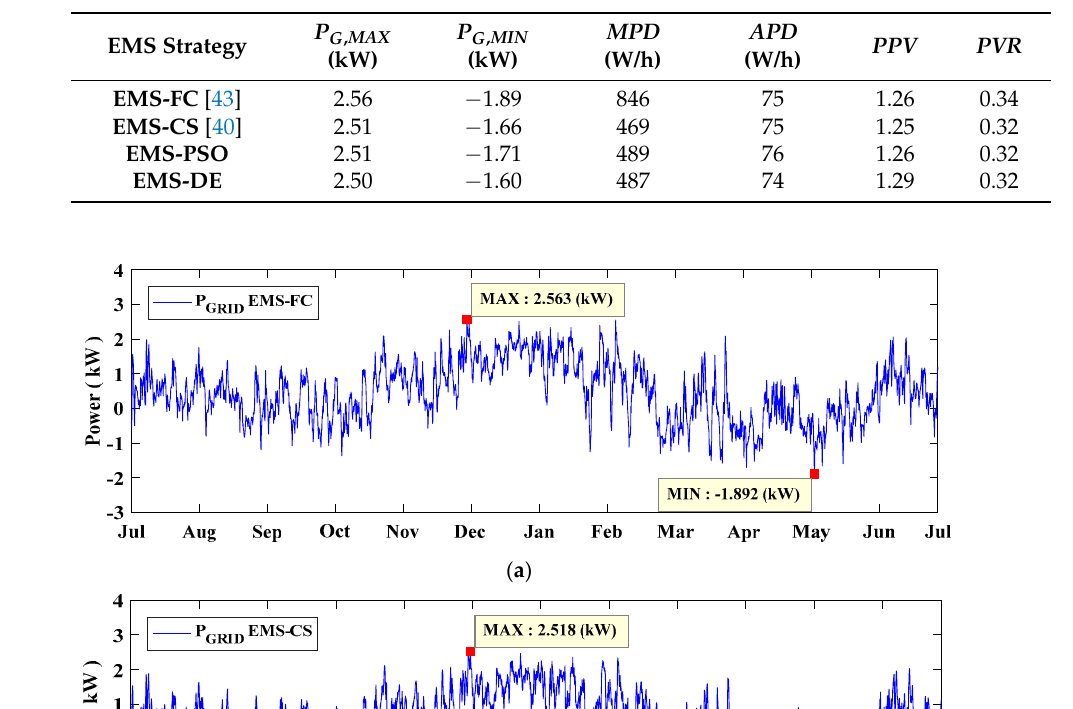
Table 8. Grid power profile quality criteria comparison.